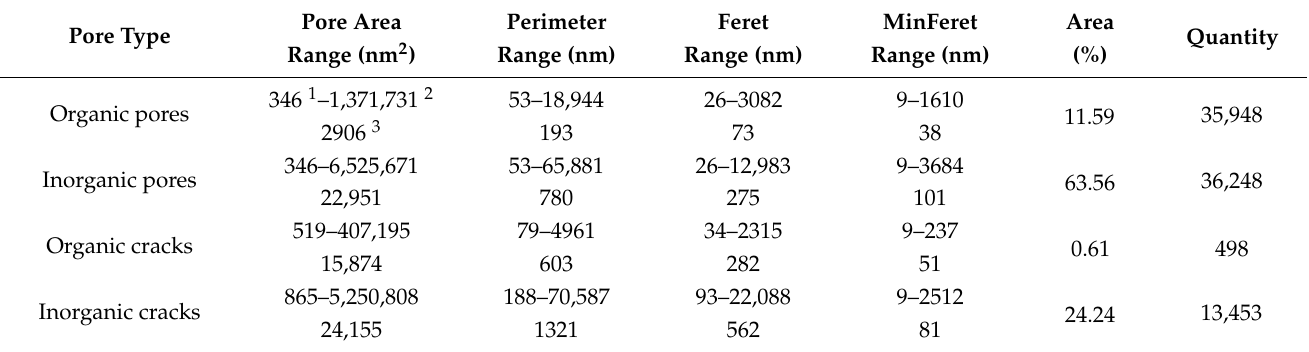
Table 1. Pore characteristic results for four pore